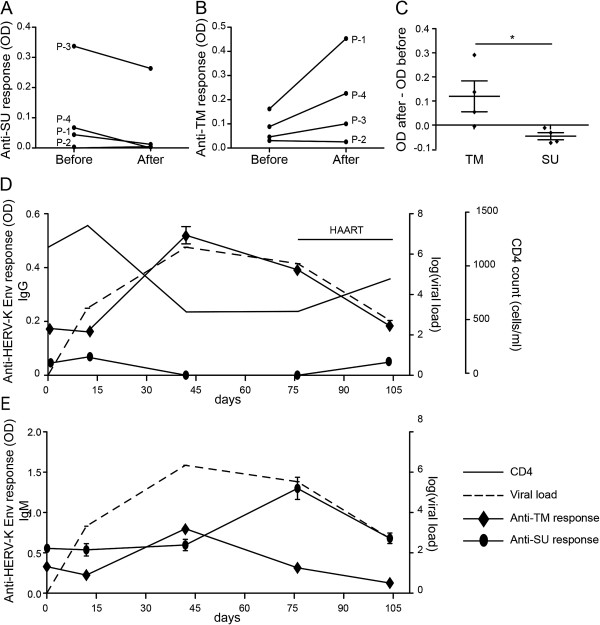
Kinetics of anti-HERV-K Env antibodies after HIV-1 infection. A,B) Comparison of the anti-SU (A) and anti-TM (B) response before and after HIV-1 infection in 4 patients. The time between the two time points did not exceed 1 month. A 1:200 sera dilution was used for this assay. C) The evaluation of the kinetics of the response was determined by the subtraction of the OD of the time point after infection by the OD of the time point before infection. A negative result meant a decrease of the response while a positive result meant an increased response. D,E) Total IgG (D) or IgM (E) anti-HERV-K TM and SU were assayed by ELISA on the same plate for 5 time points (1:200 dilution) for the patient OP-1830. The thin black line represents the CD4+ T cell count (cells/mm3) and the hatched line the log10 of the HIV-1 copy number/mm3. Statistical analyses were performed using the Mann & Whitney t-test; *p < 0.05. Results are typical of three independent experiments.